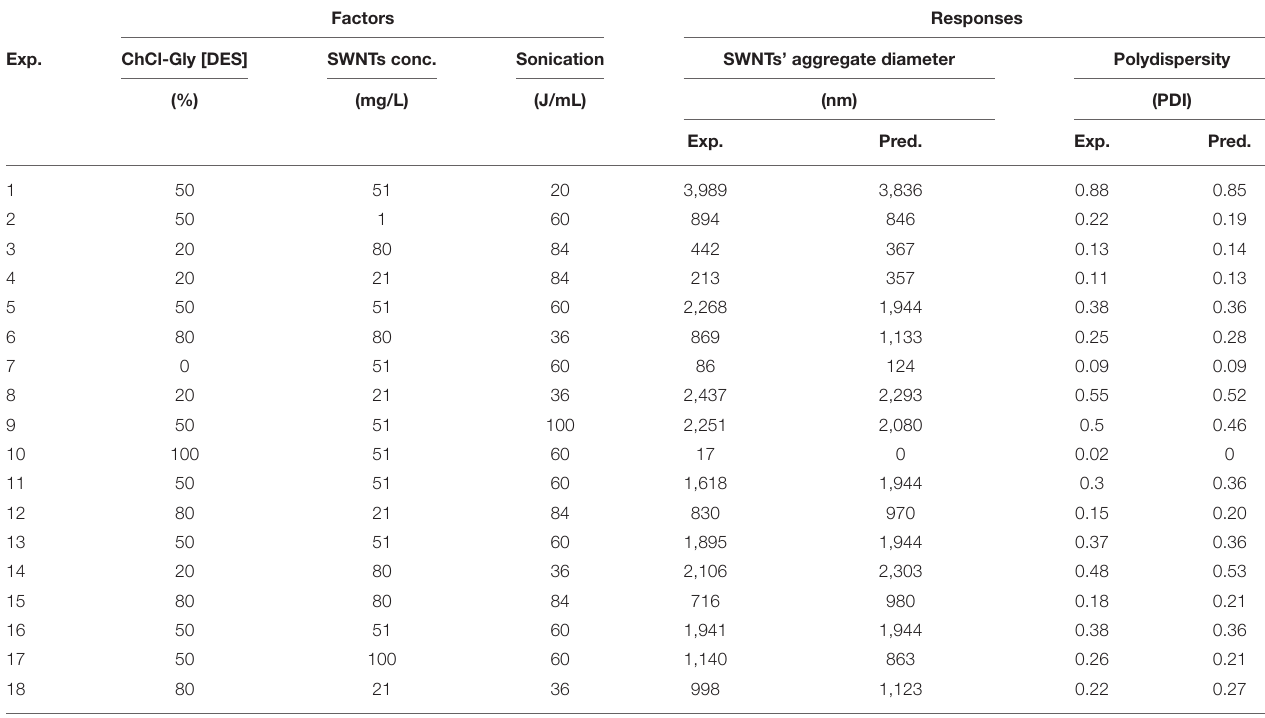
TABLE 3 | Empirical models representing SWNTs aggregate diameter and polydispersity in the aqueous ChCl-Gly DES system. Parameter Model Coded/ SWNTs’ aggregate diameter (nm) = SWNTs’ Polydispersity index (PDI)